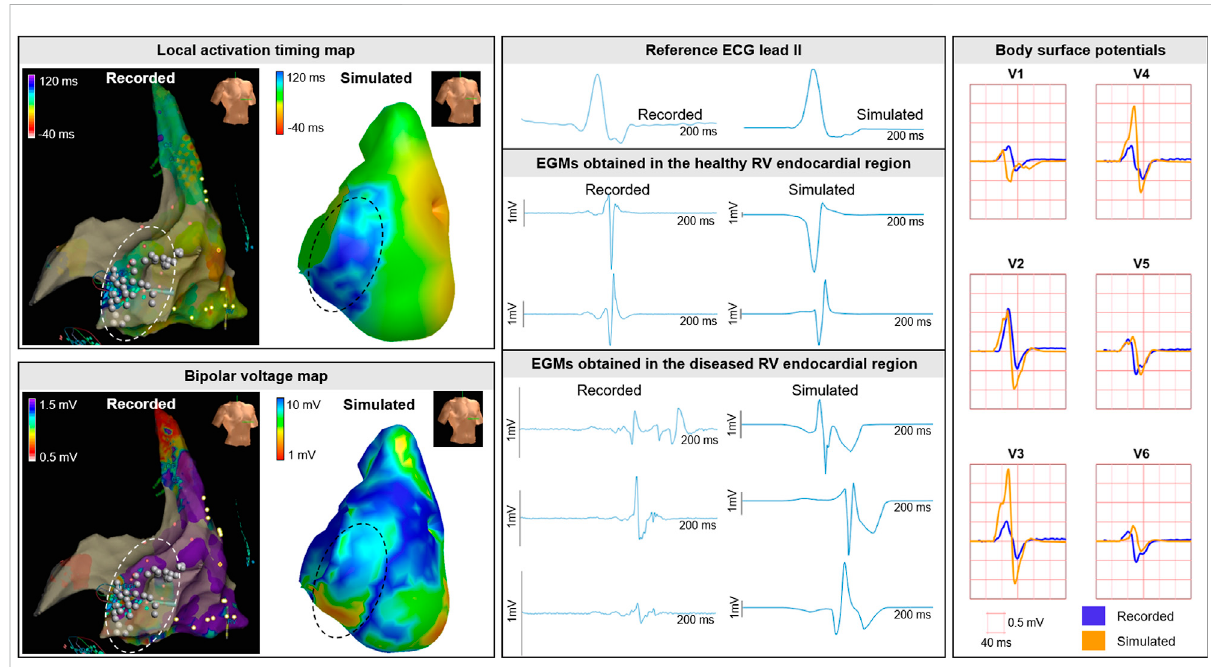
FIGURE 10 Clinical EAM case. Recorded and simulated electro-anatomical mapping (EAM). Local activation timing and bipolar voltage maps of the RV endocardium are displayed from red (early/low) to blue (late/high). Recorded and simulated bipolar cardiac electrograms are displayed for healthy and diseased regions. Within diseased regions (dashed circles), fragmentation and late potentials occur in recorded and simulated electrograms. Ablation was performed and indicated with the white dots. Recorded and simulated body surface potentials. The BSP is displayed per lead for the QRS complex for the precordial signals V1-V6 from the standard 12-lead ECG. One cube in the 12-lead ECG corresponds to 40 ms (width) and 0.5 mV